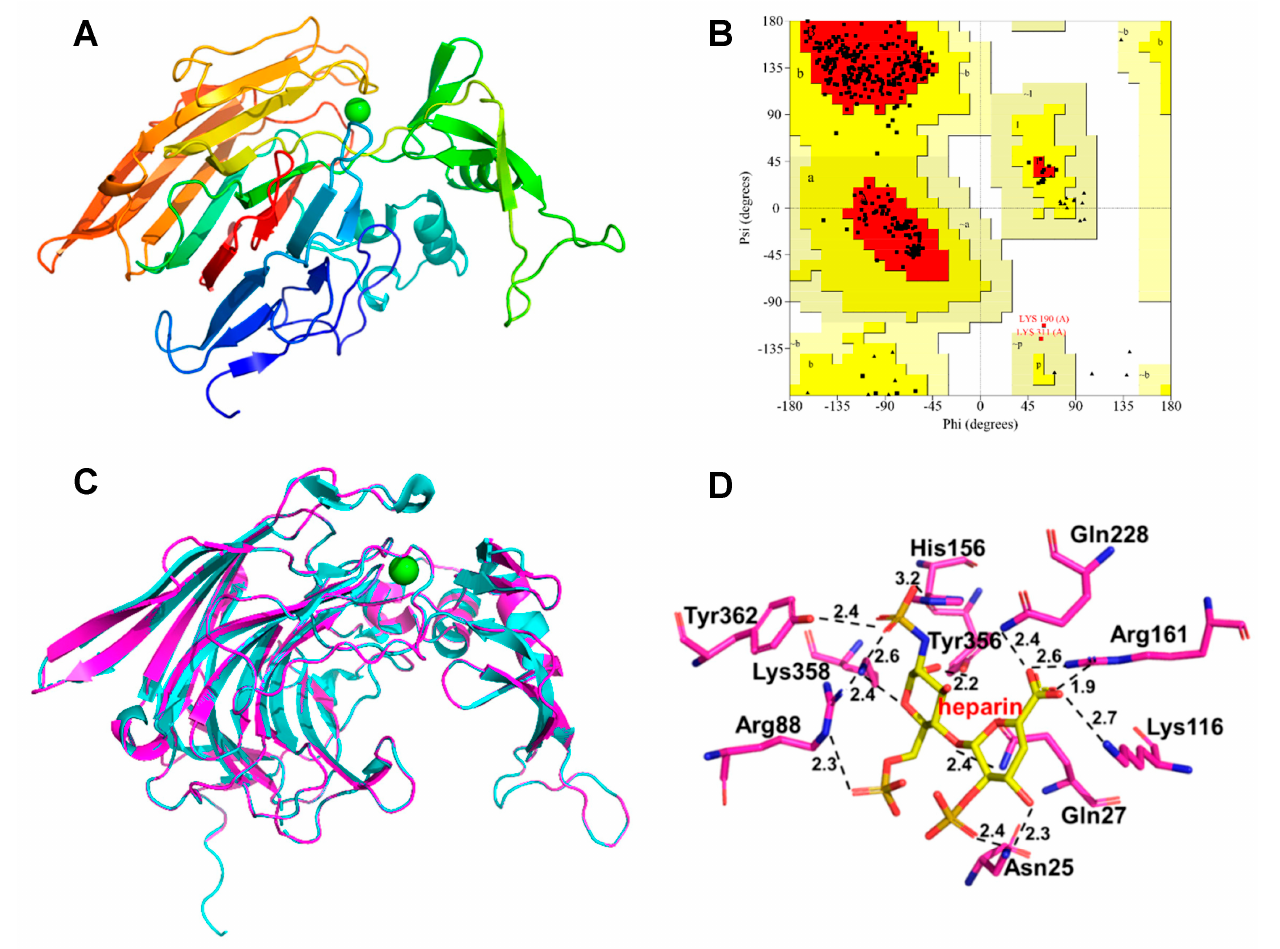
Figure 5. Homology modeling of BxHep-I and molecular docking with heparin. ( A ) a model of BxHep-I, ( B ) Ramachandran plot of BxHep-I, ( C ) The superimposition of the template (BtHep-I, 3ikw, blue) and BxHep-I (red), ( D ) molecular docking of BxHep-I with heparin).